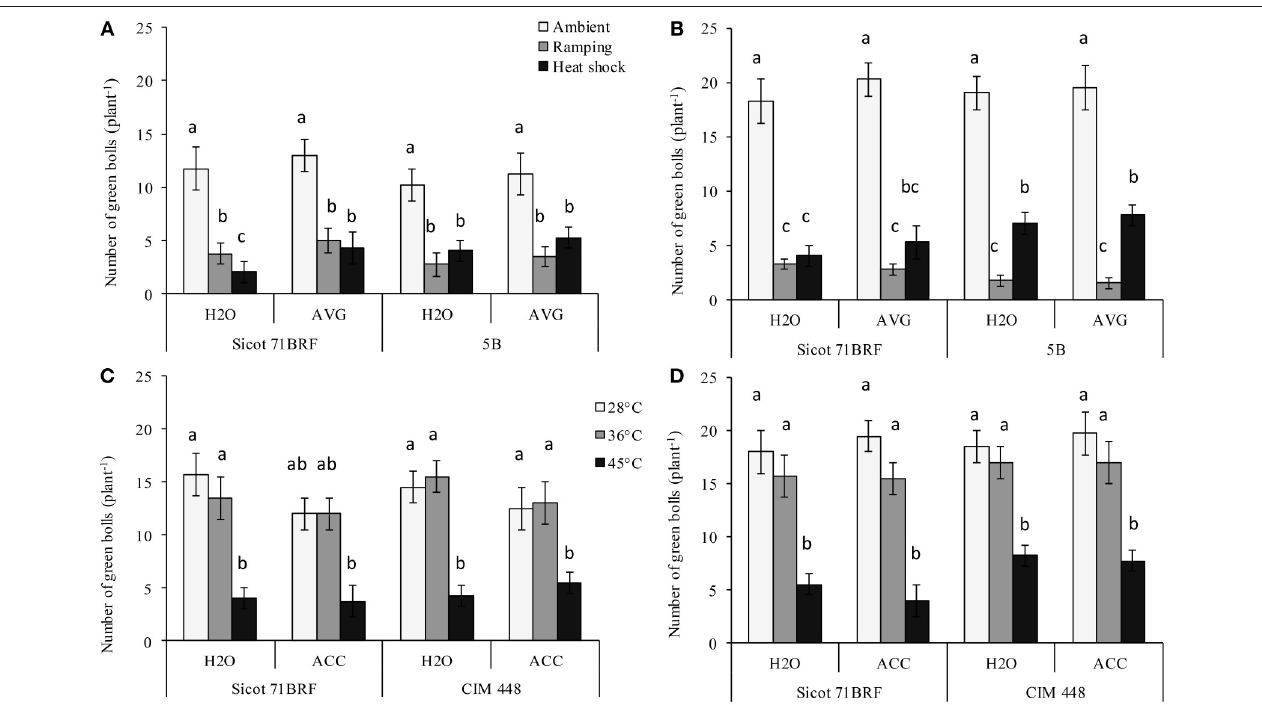
FIGURE 1 | Effect of aminoethoxyvinylglycine (AVG) on number of green bolls (pollinated flowers + bolls) in cotton genotypes Sicot 71BRF and 5B exposed to heat shock (45 ◦ C) and ramping heat (gradual rise in temperature to 45 ◦ C) for 7 days. Data were collected (A) on the last day of heat treatment and (B) 15 days of recovery after the heat treatment. Values are the mean of four independent replications, with the error bars representing SE. Effect of 1-aminocyclopropane-1-carboxylic acid (ACC) on the number of green bolls in cotton genotypes Sicot 71BRF and CIM 448 exposed to heat shock (45 and 36 ◦ C) for 7 days. Data were collected (C) on the last day of heat treatment and (D) 15 days of recovery after the heat treatment. Values are the mean of four independent replications with the error bars representing SE and sample size = 4. Means sharing same letters within each figure are not significantly different at α =